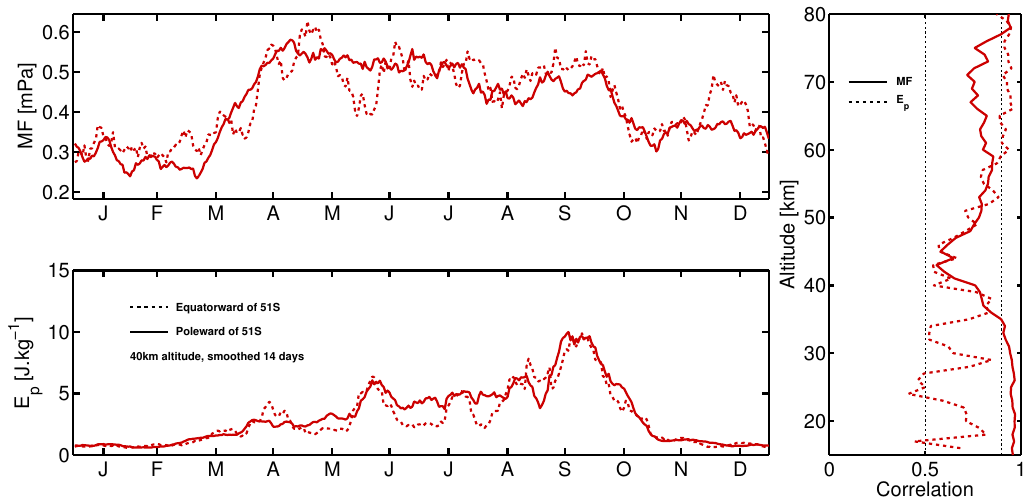
Figure 8. Annualised HIRDLS-derived (a) GWMF and (b) GWPE for the boxed region illustrated in Fig. 7, divided into (dotted) equatorward and (solid) poleward of 51 ◦ S regions. Data shown are at 40km and smoothed by 7 days. (c) Pearson linear correlation (“ c ”) between poleward and equatorward regions for (solid) GWMF and (dashed) GWPE annualised time series (smoothed 14 days) at each height level in the HIRDLS data set. c = 0 . 5 and c = 0 . 9 are indicated with dotted black lines for